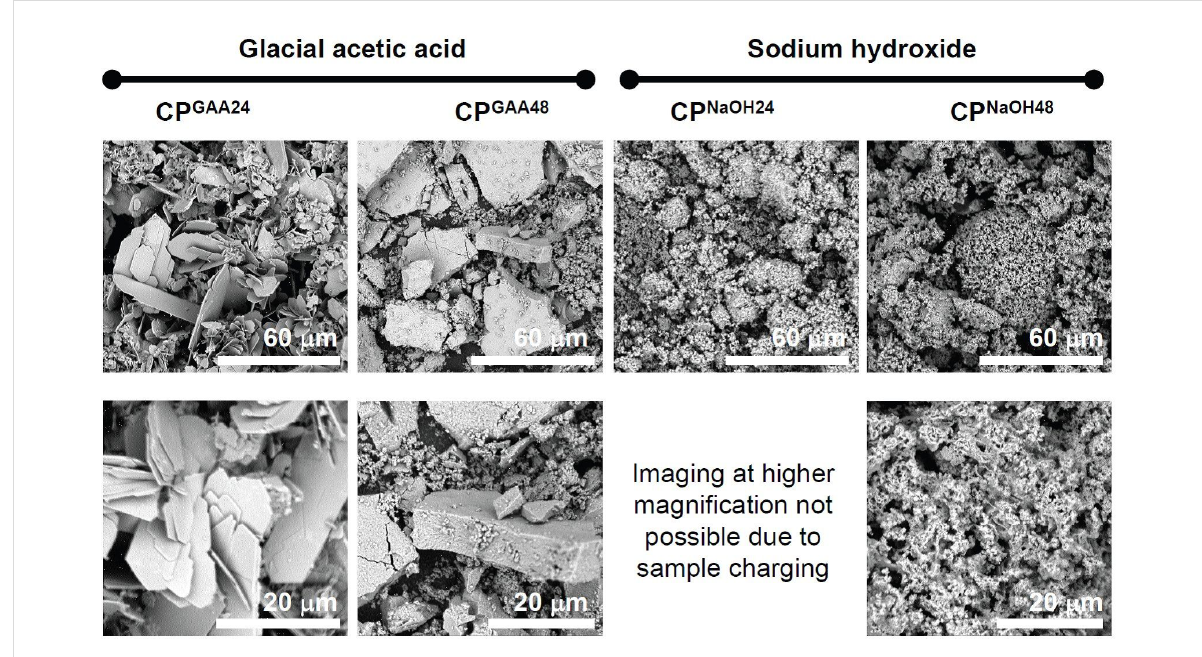
Figure 2: Low magnification (top row) and higher magnification (bottom row) SEM images of the precipitates. High magnification imaging of CP NaOH24 led to rapid sample charging and very poor imaging conditions even after sputtering; no image is thus shown.